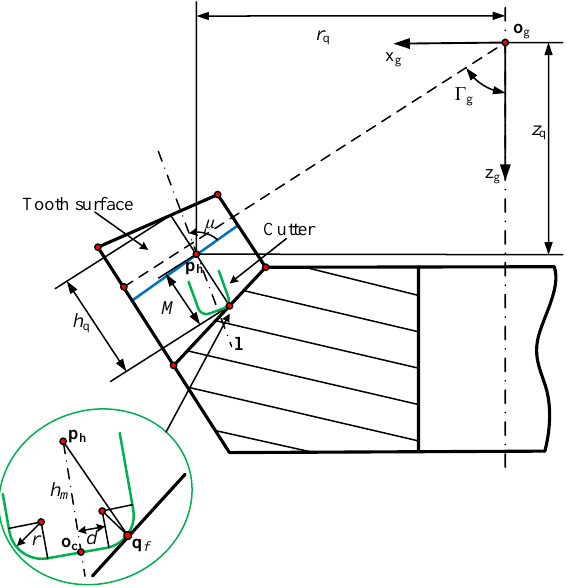
Figure 4. Cutter constraints in